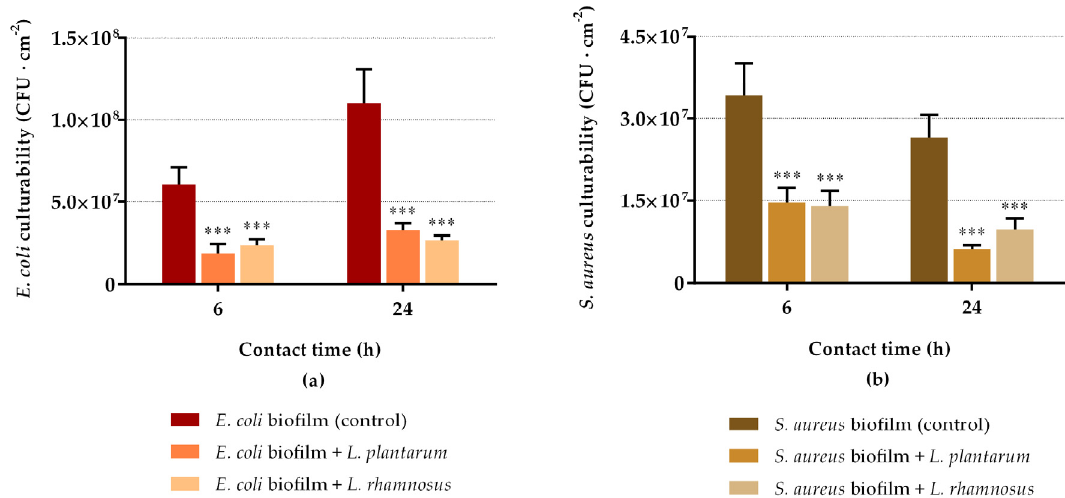
Figure 1. Culturability of 24 h biofilms of E. coli ( a ) and S. aureus ( b ) after 6 h and 24 h of contact with probiotics ( L. plantarum or L. rhamnosus ). The data present the mean and standard deviation (SD) of at least three independent experiments. Statistically significant differences between the control and treatment were considered for p -values < 0.05 (*** indicates p < 0.001).